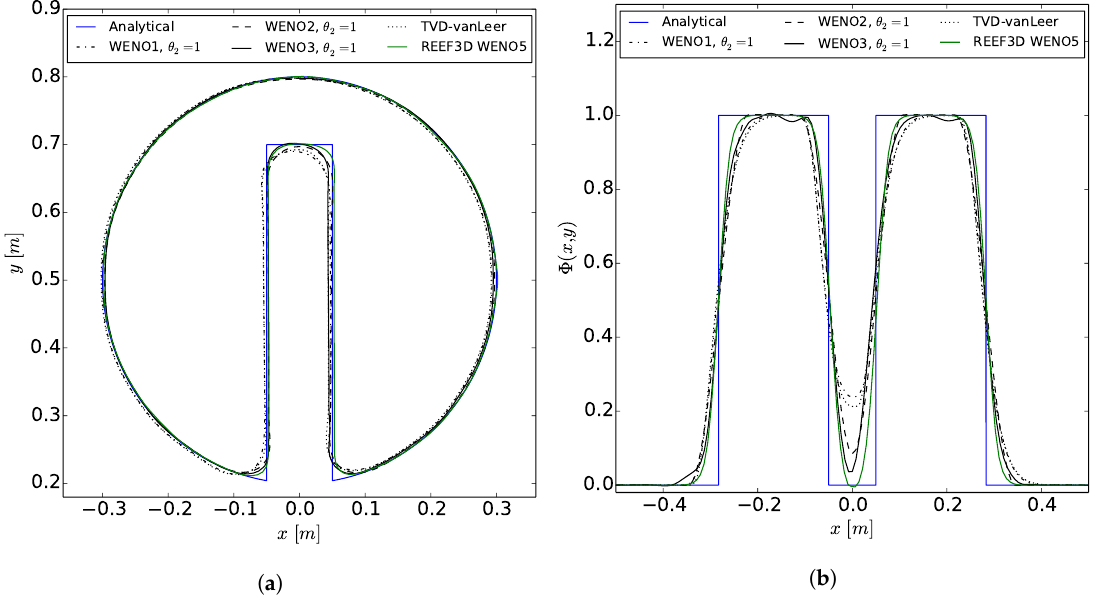
Figure 18. Results of convection schemes for Zalesak’s disk on 256 Φ = 0.5; ( b ) slice of the disk at y = 0.6